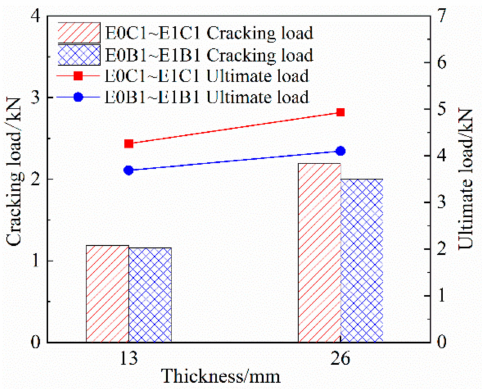
Figure 6. Effect of ECC substrate thickness on tensile properties of